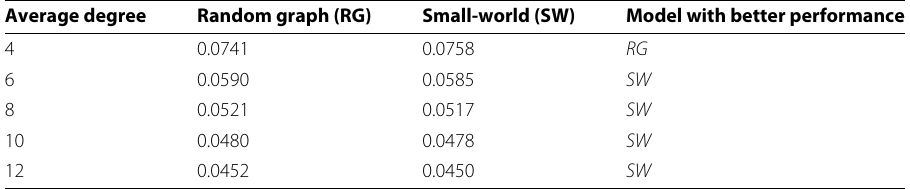
Table 2 Performance comparison of Energy Loss Ratio between the small-world and the random graph Average degree Random graph (RG) Small-world (SW) Model with better